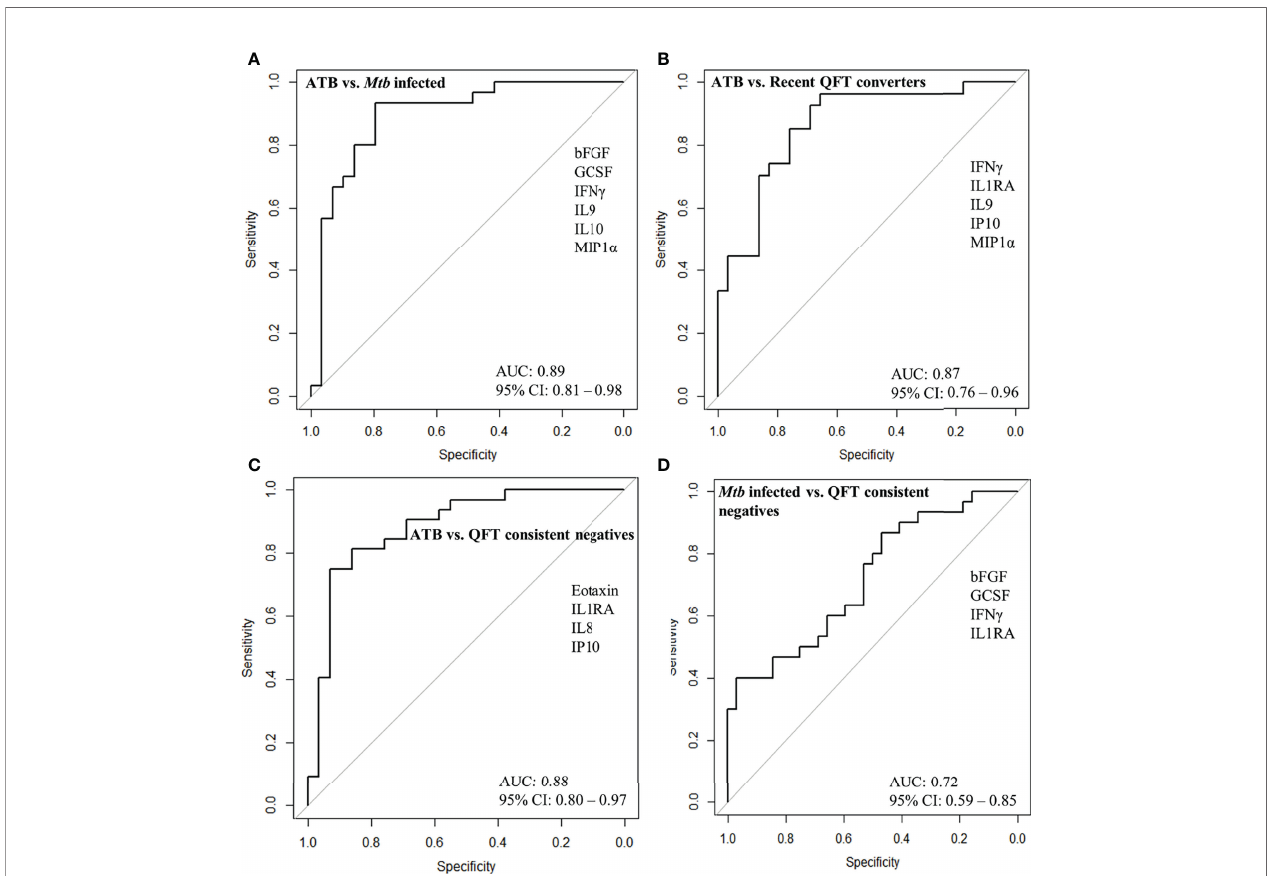
FIGURE 4 | ROC curves for protein signature that distinguishes (A) Active TB (ATB; n = 29) from Mtb infected (n = 30), (B) ATB (n = 29) from recent QFT converters (n = 27), (C) ATB (n = 29) from QFT consistent negatives (n = 32), and (D) Mtb infected (n = 30) from QFT consistent negatives (n =